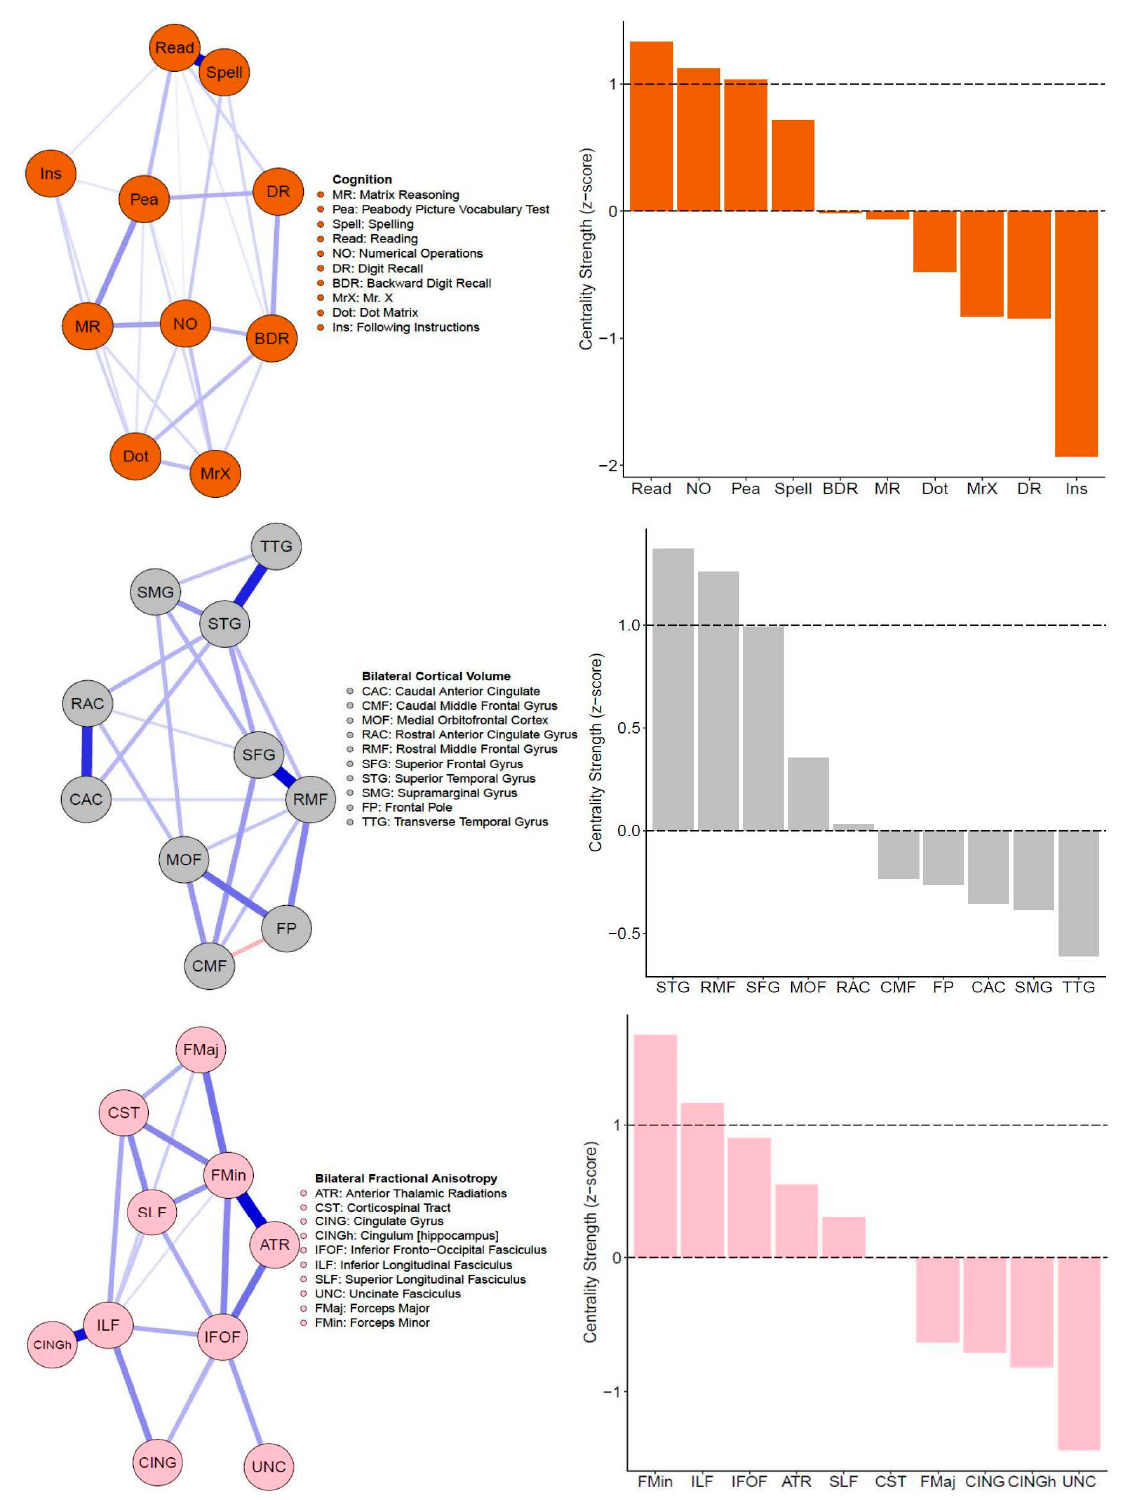
Figure 2. Single-layer partial correlation networks. Top: Network visualization (spring layout, left ) of CALM cognitive data (N = 805). Centrality estimates (z-scores) of all cognitive tasks ( right ). Middle: Network visualization (spring layout, left ) of CALM cortical volume data (N = 246). Centrality estimates (z-scores) of all cortical volume nodes ( right ). Bottom: Network visualization (spring layout, left ) of CALM fractional anisotropy data (N = 165). Centrality estimates (z-scores) of all fractional anisotropy nodes ( right ). Dashed lines in centrality plots indicate mean strength and one standard deviation above the mean.